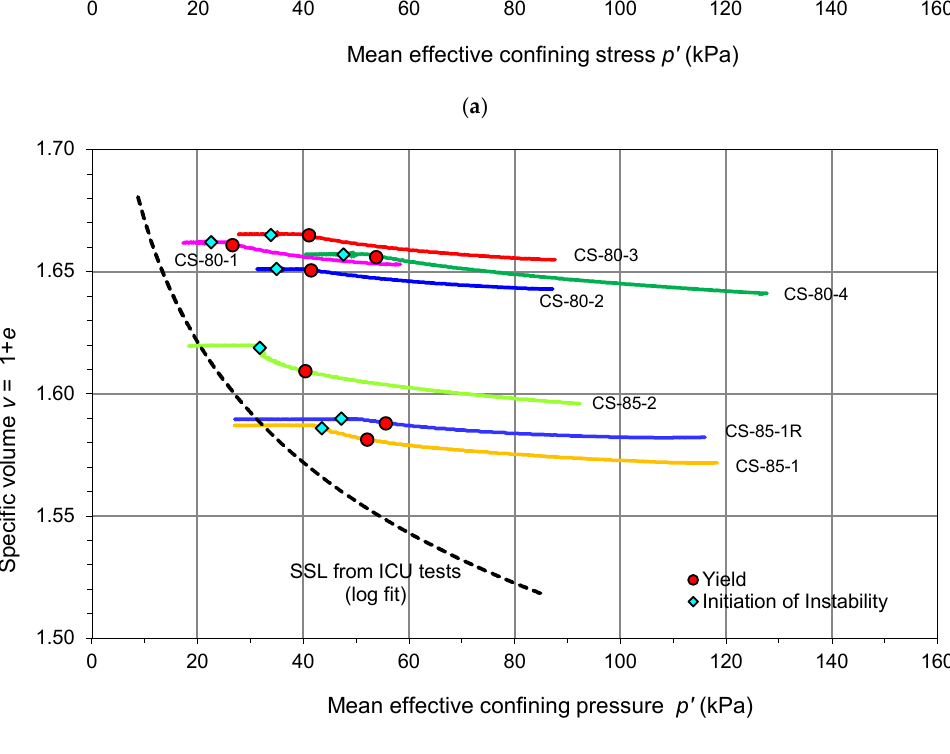
Mean effective confining pressure p' (kPa)